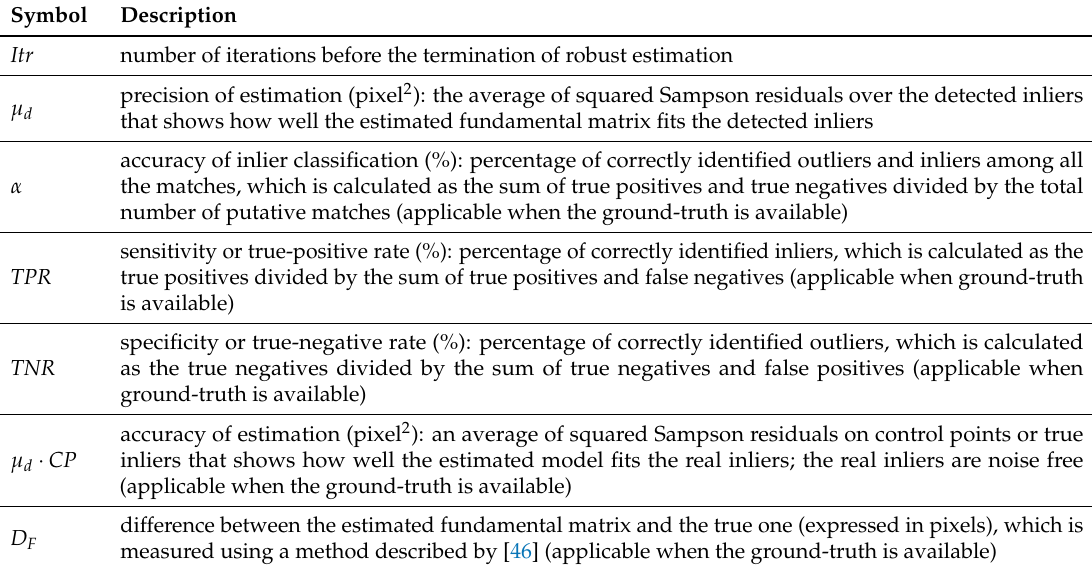
Table 1. Criteria for performance